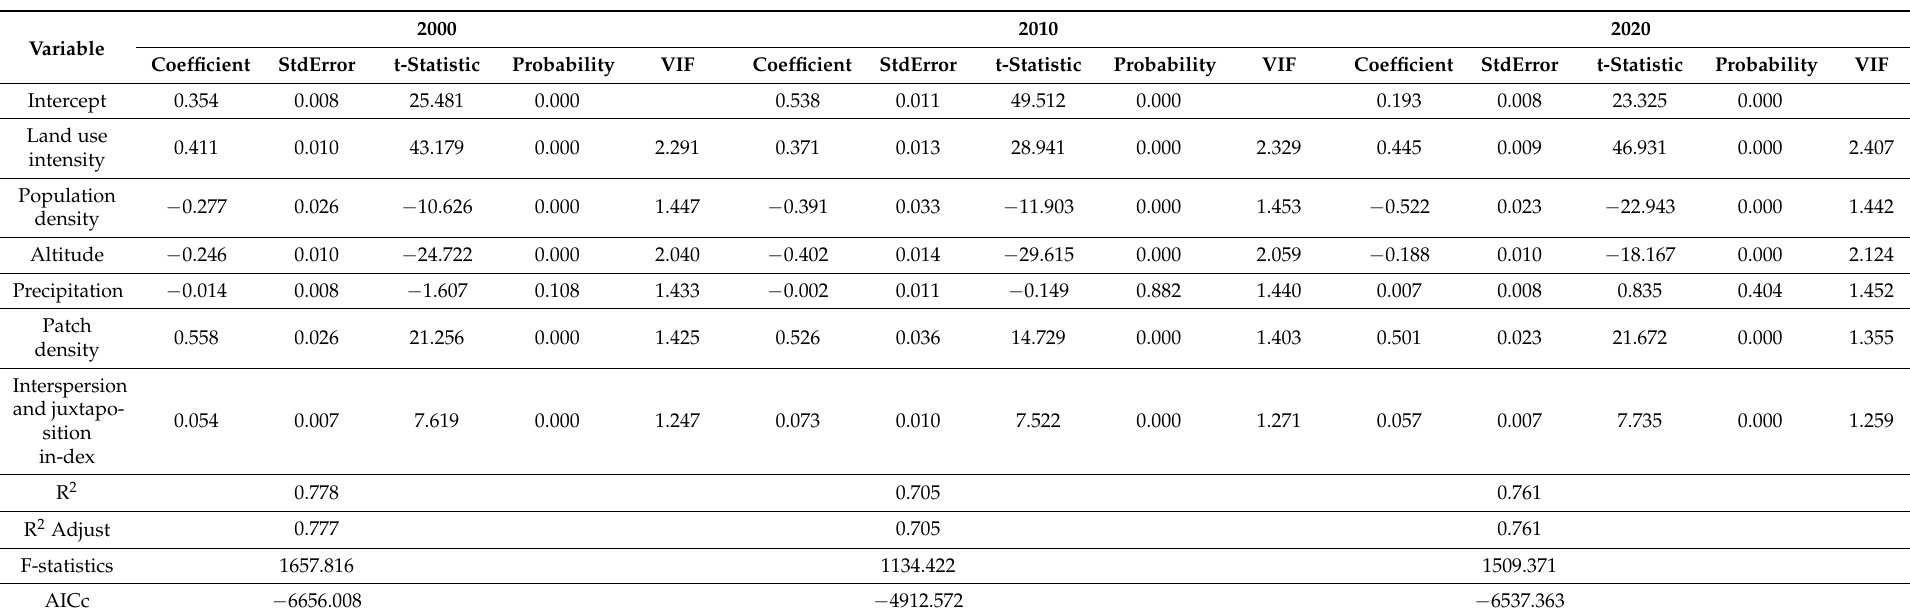
Table 4. Regression results of OLS model during